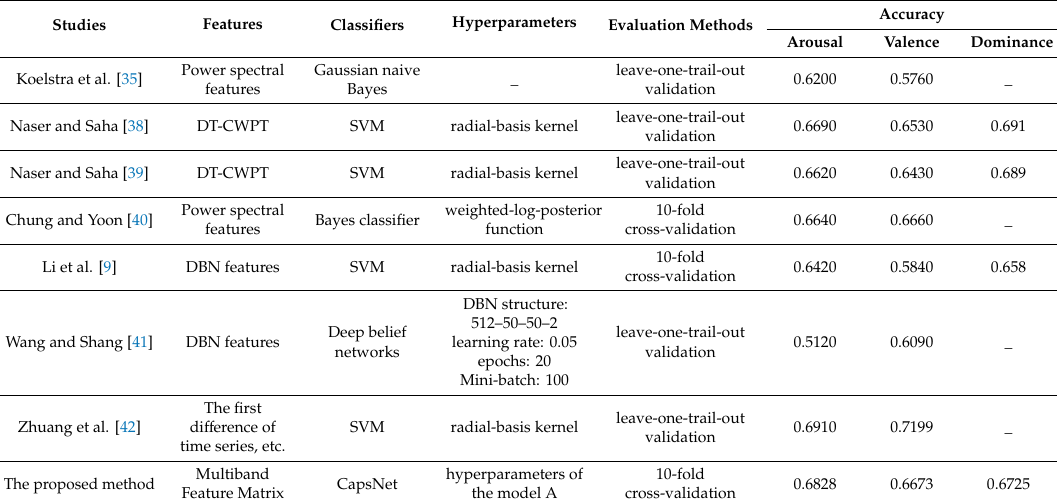
Table 4. Details of several reported studies. DT-CWPT: dual-tree complex wavelet packet transform.